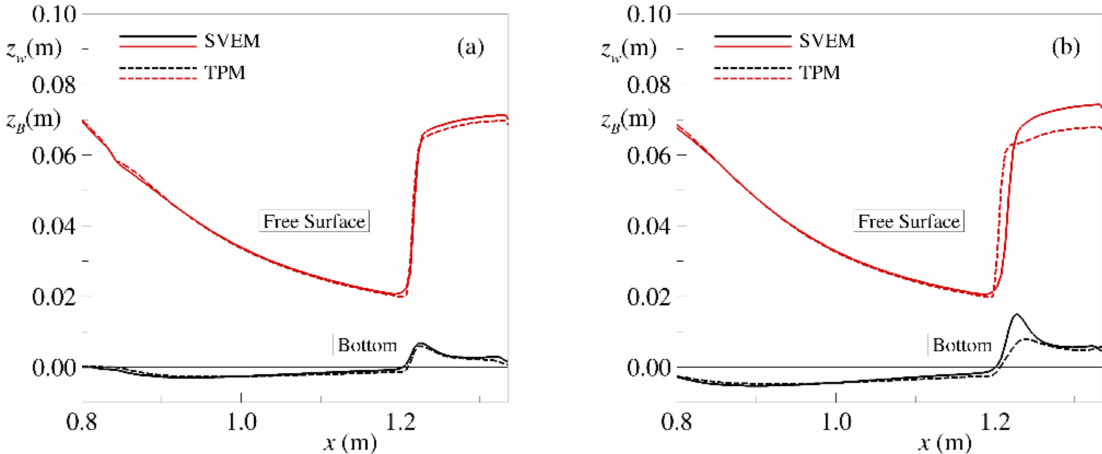
Figure 5. Spatial free surface (z w ) and bottom (z B ) evolution for the test with sand particles at t = 1.5 s and y = 0.6 m SVEM vs. TPM: ( a ) d = 5 × 10 − 3 m; ( b ) d = 5 × 10 − 4 m.